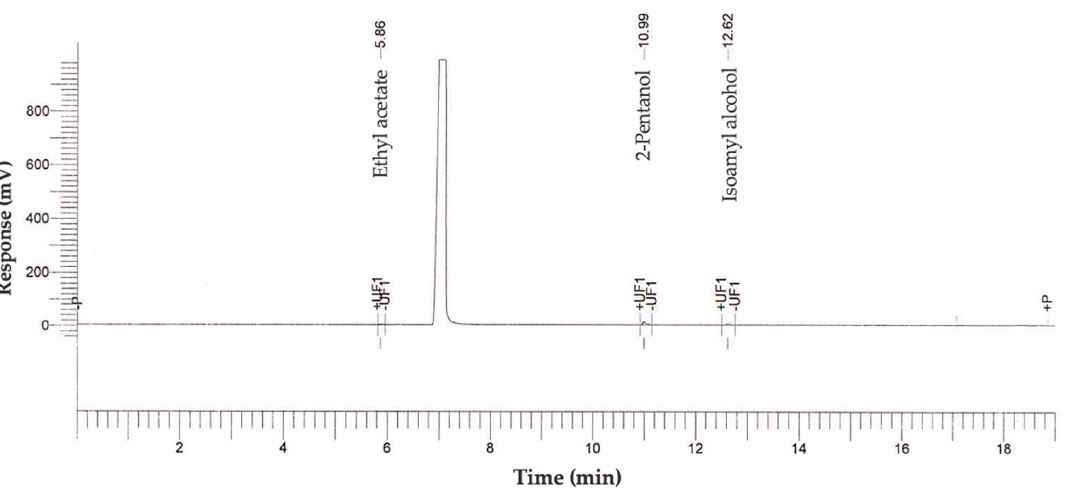
Figure 2. Chromatographic profile of methanol, esters, aldehydes, and higher alcohols of the beer prepared from Pichia kudriavzevii 4A.